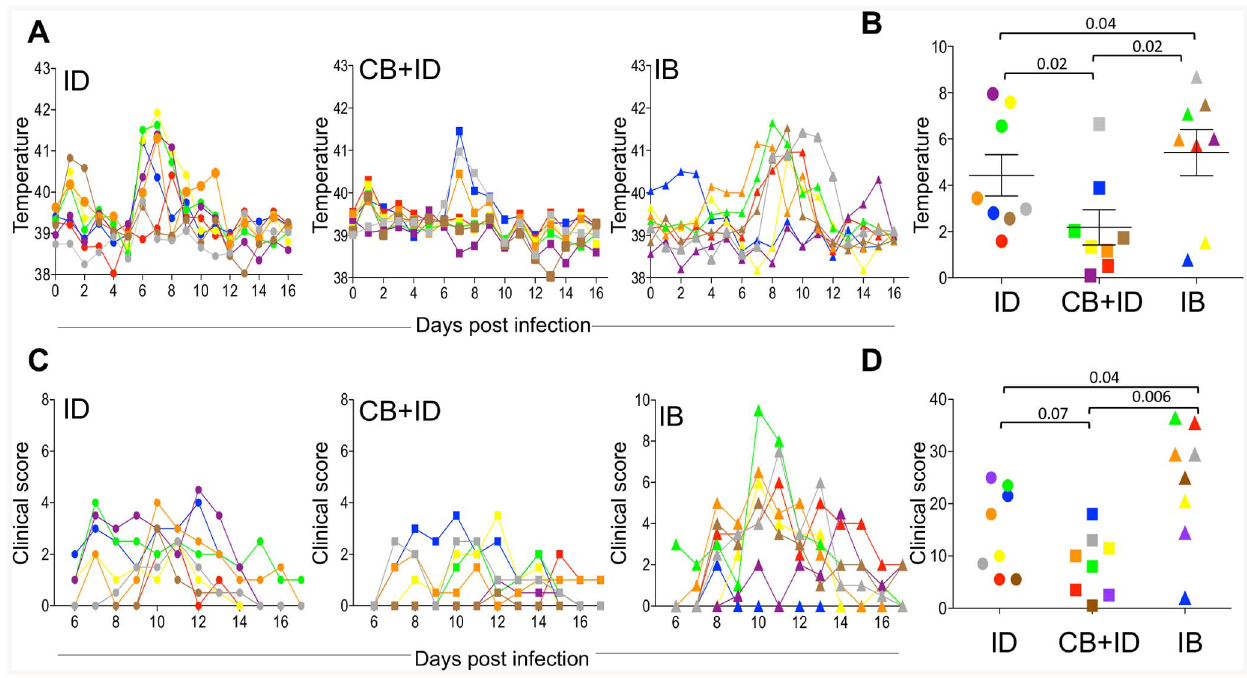
Figure 2. Body temperature and clinical scoring in needle and C.nubeculosous- infected sheep. A. Body temperature was monitored for each sheep over 17 days. B. The increase in temperature over time was calculated relatively to day 0 and the peak area under the curve was calculated for each sheep. C. A clinical score was evaluated for each sheep and reported from 6 to 17 dpi in B. D. The integrated area under the curve of the clinical scores from 6 to 17 dpi was calculated for each sheep. The same color and shape are used for each sheep as in Fig. 1. Statistical comparisons between 2 groups were done with a Mann-Whitney U test and the p values are reported to show significance and major tendencies.